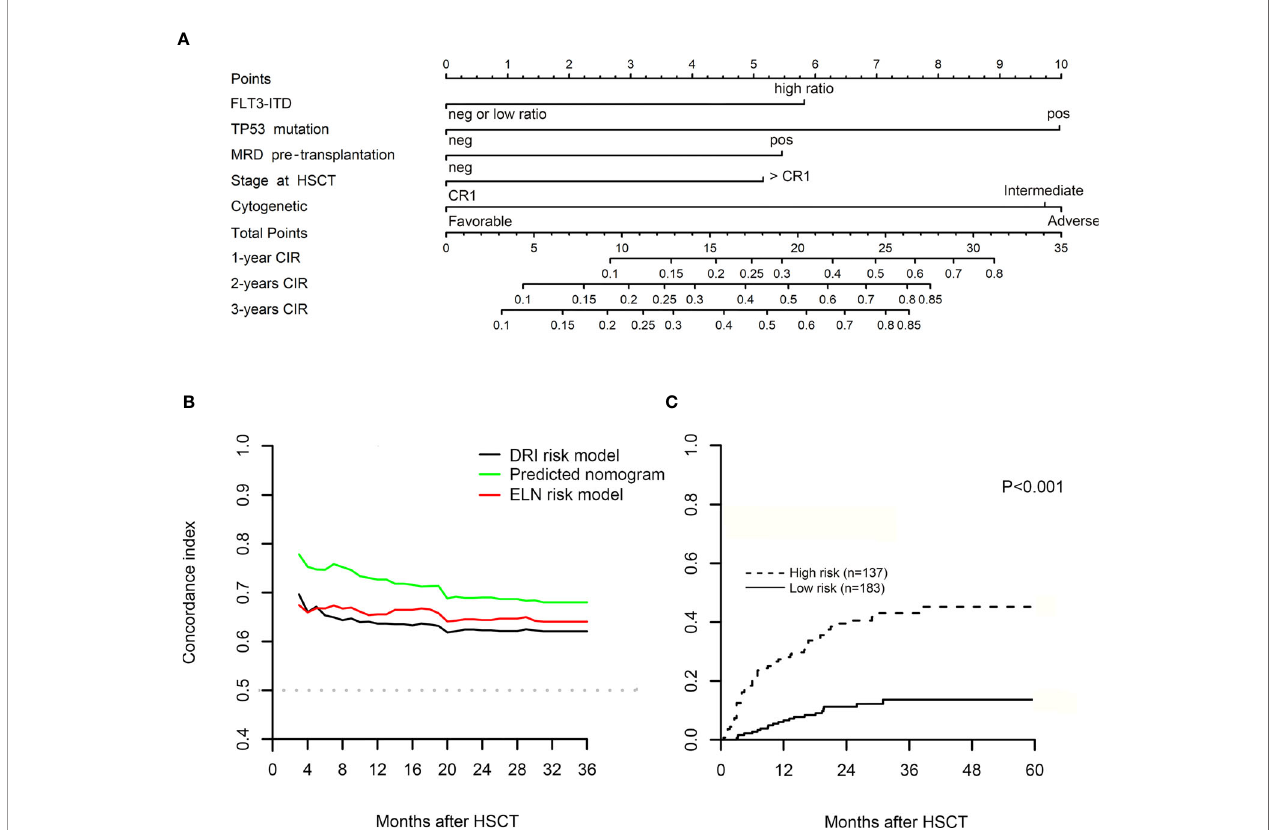
FIGURE 2 | (A) Competing risk nomogram for predicting leukemia recurrence in acute myeloid leukemia (AML) patients with myeloablative conditioning (MAC) regimen in 1, 2, and 3 years after allogeneic hematopoietic stem cell transplantation (allo-HSCT). In the nomogram, the sum of fi ve variable points is located on the axis of total points, and a line is drawn downward to the cumulative incidence of relapse (CIR) axes to determine the probability of 1-, 2-, and 3-year CIR. (B) The diagrams of the concordance index (C-index) after allo-HSCT. (C) The plot of CIR after risk strati fi cation of the nomogram in the training cohort. By using the scoring system from the nomogram, the median cutoff value was adopted to divide the training cohort into two subgroups after ranking by total score (score: from 0 to 9.73 and from 9.73 to 30.58). Gray ’ s test was used to examine the difference in CIR between groups. MRD, minimal residual disease; ELN, European LeukemiaNet recommendations; DRI, re fi ned Disease Risk